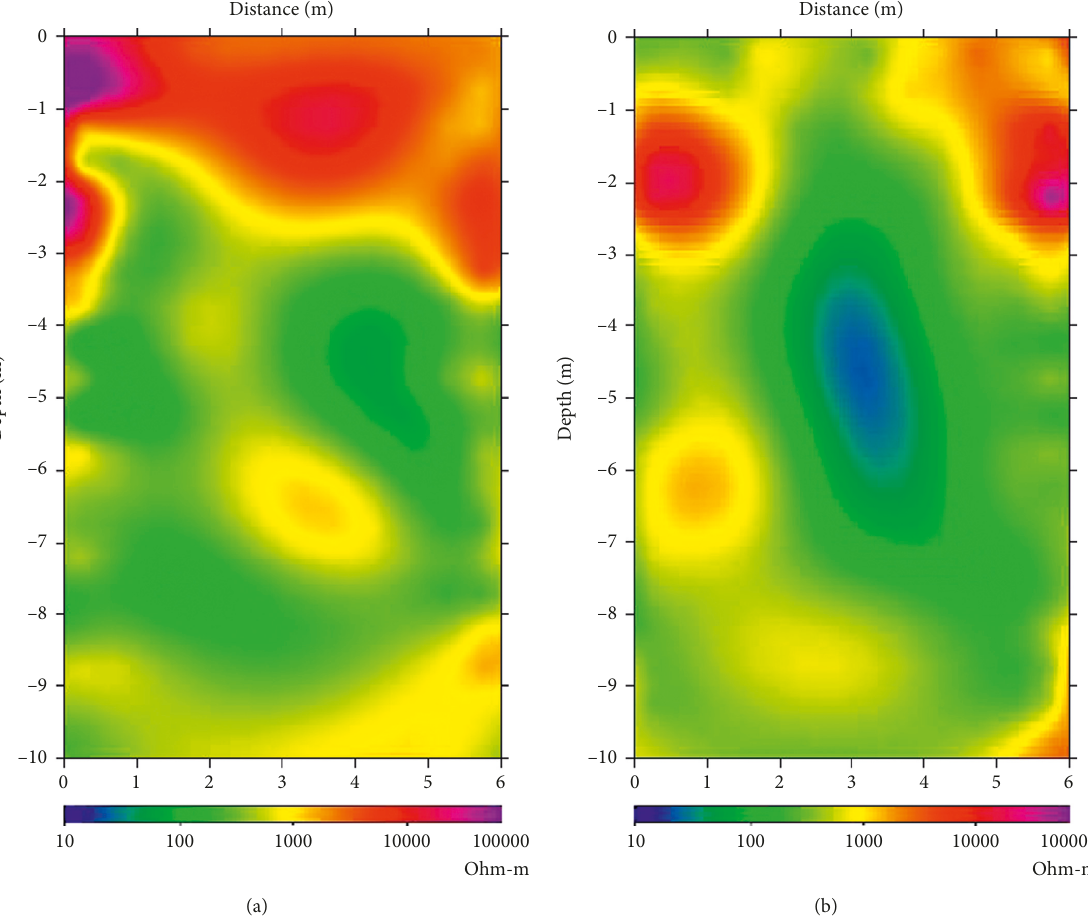
Figure 10: Electrical resistivity contours of 1st test (a) and 2nd test